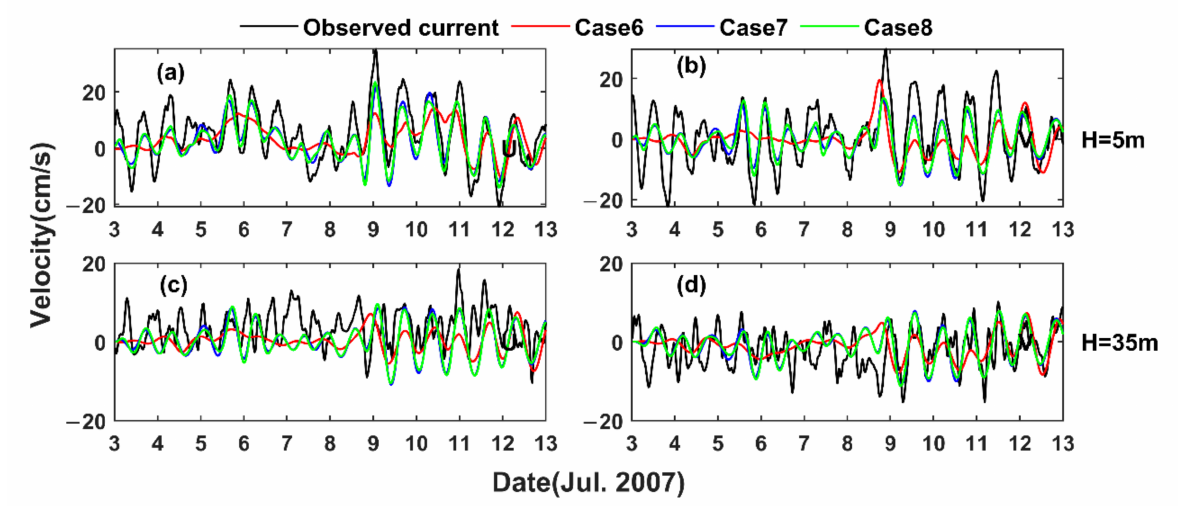
Figure 11. The time series of observed and inverted ( left ) eastward and ( right ) northward velocity at ( a , b ) 5 m depth; ( c , d ) 35 m depth in Cases